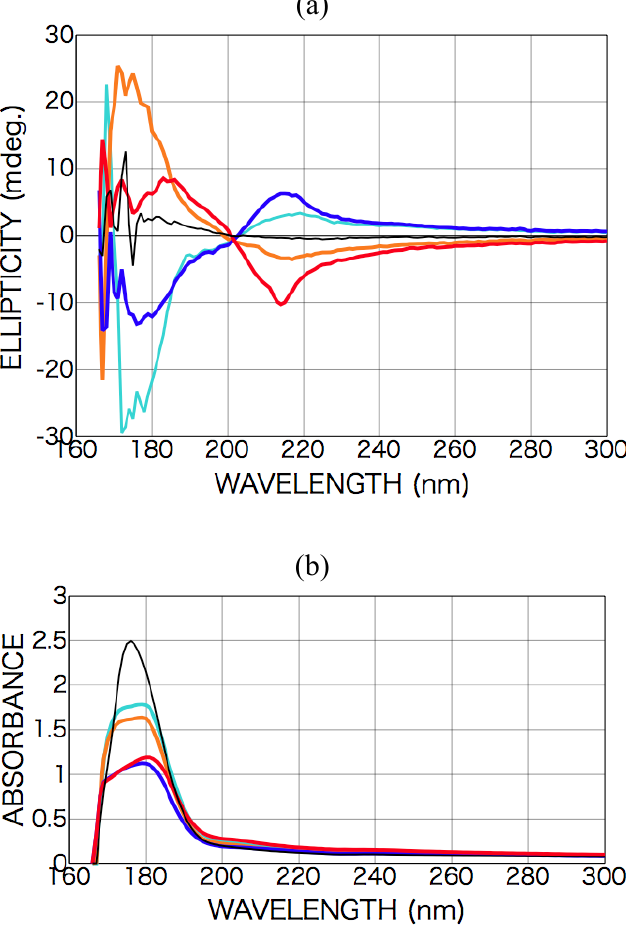
Figure 10. (a) CD spectra of DL -alanine films (250-nm in thickness) after CPL irradiation (colored). Left-handed CPL [orange (2 mWhour) and red (10 mWhour)]; right-handed CPL (light blue and blue). Dependence on the irradiation dose is also shown. (b) Photo absorption spectra of DL -alanine films as-deposited (black) and after CPL irradiation (colored). Left-handed CPL (orange and red); right-handed CPL [light blue (2 mWhour) and blue (10